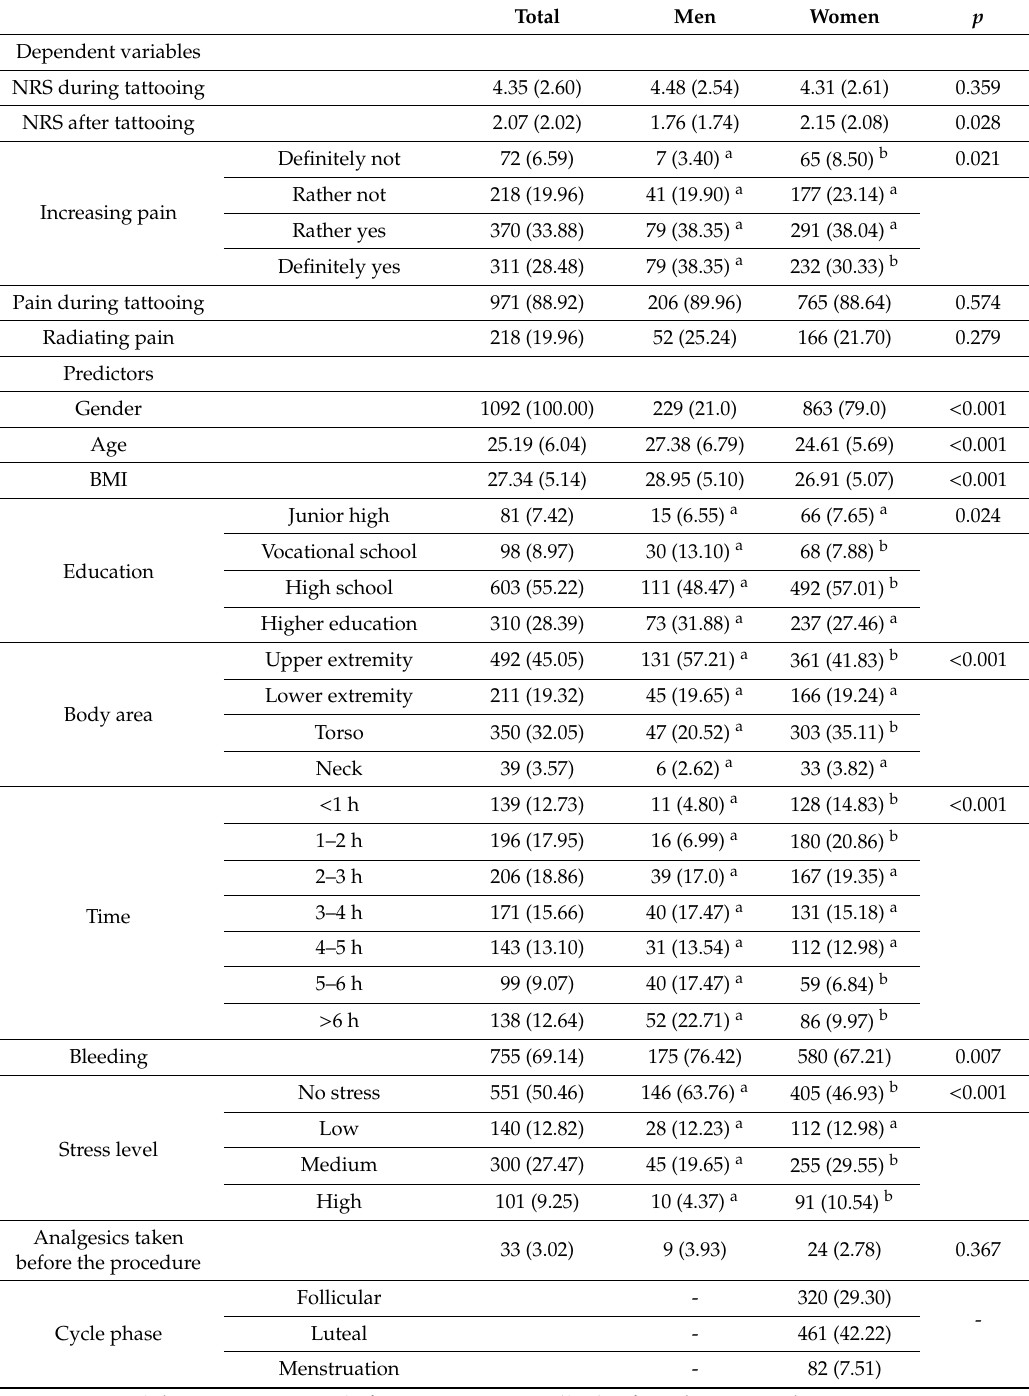
Table 1. Descriptive results for predictors and dependent variables and gender di ff